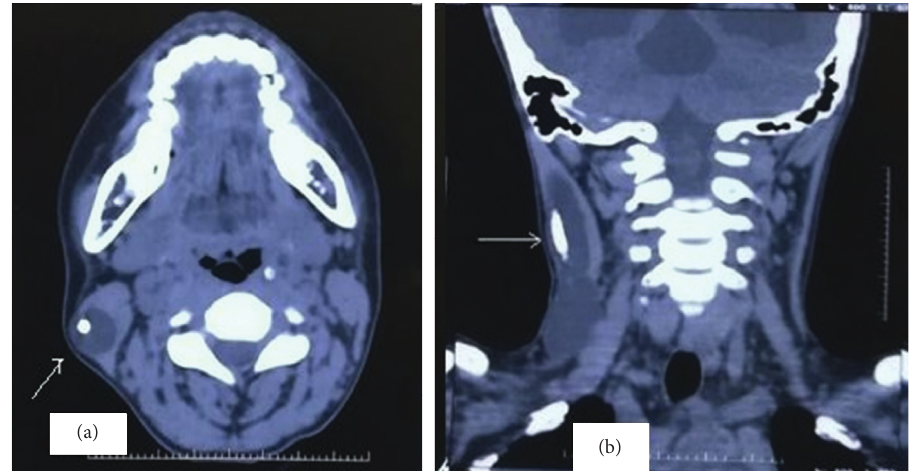
Figure 5: (a, b) Noncontrast computed tomogram of neck, coronal and axial sections showing the CSF pseudocyst involving the ster- nocleidomastoid on the right side with VP shunt in situ (white arrow).